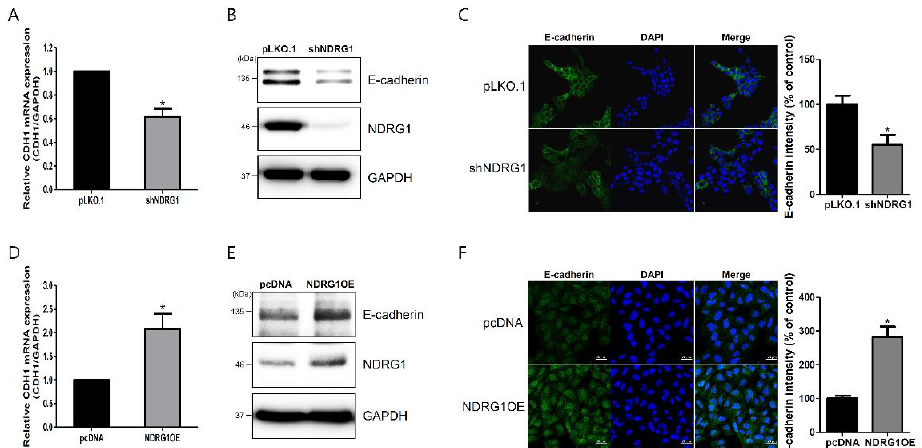
Figure 4. NDRG1 positively regulated E-cadherin expression in endometrial epithelial cells. ( A ) Effect of NDRG1 depletion on CDH1 mRNA expression in RL95-2 cells. ( B ) Effect of NDRG1 depletion on E-cadherin protein expression in RL95-2 cells. ( C ) Immunofluorescence images of E-cadherin expression following NDRG1 depletion in RL95-2 cells. ( D ) Effect of NDRG1 overexpression on CDH1 mRNA expression in AN3-CA cells. ( E ) Effect of NDRG1 overexpression on E-cadherin protein expression in AN3-CA cells. ( F ) Immunofluorescence images of E-cadherin expression induced by NDRG1 overexpression in AN3-CA cells. All images are shown at 400 magnification. Scale bars indicate 20 μ m. Nuclei were stained with 4 ′,6′ -diamidino-2-phenylindole dihydrochloride (DAPI). Quantification of immunofluorescence images using image J. The data shown represent the mean ± SEM from three independent experiments (n = 3). * p < 0.05.